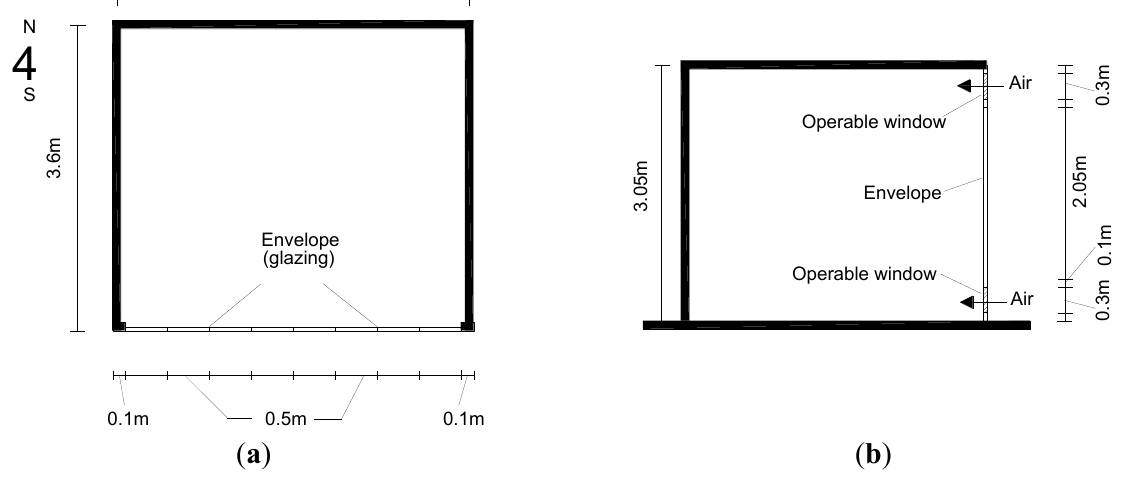
Figure 7. Layout of tested building (single skin envelope, ( a ) plan; ( b )